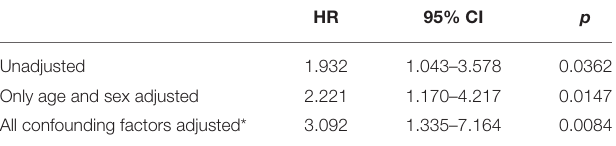
TABLE 4 | Different HR values in survival